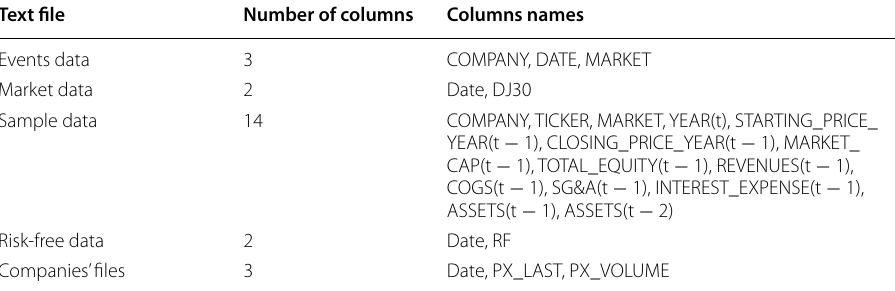
Table 3 Text file